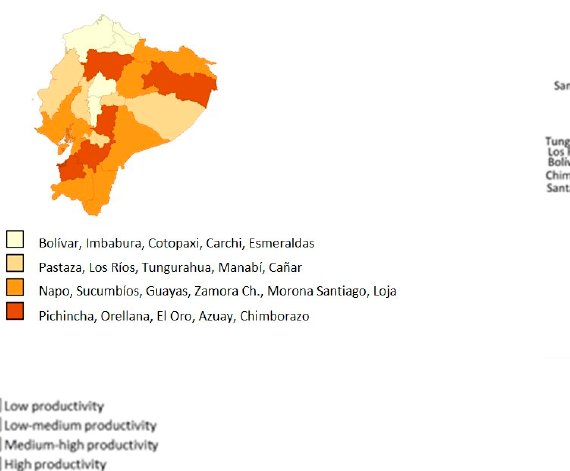
Figure 2. Quantiles of provincial productivity 2007, 2012, and 2017. Source: Own elaboration based on the Regional Accounts of the BCE (2017) [46], and ENEMDU Surveys from the INEC [47] (several years).